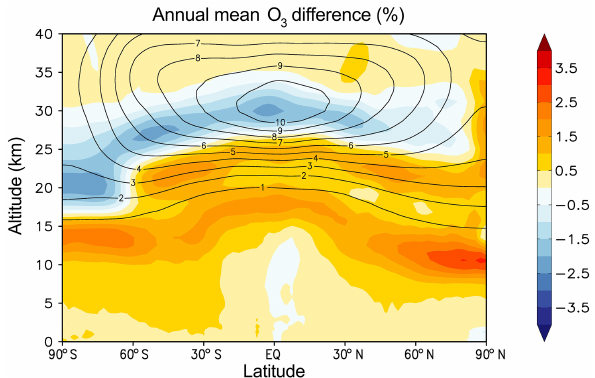
Figure 8. Simulated annual-mean, zonal-mean O 3 percentage dif- ferences between TiO 2 injection (S3) and the Mt Pinatubo erup- tion (S2). Black contour lines show ClO x mixing ratios from the Mt Pinatubo simulation (S2) in parts per million by volume